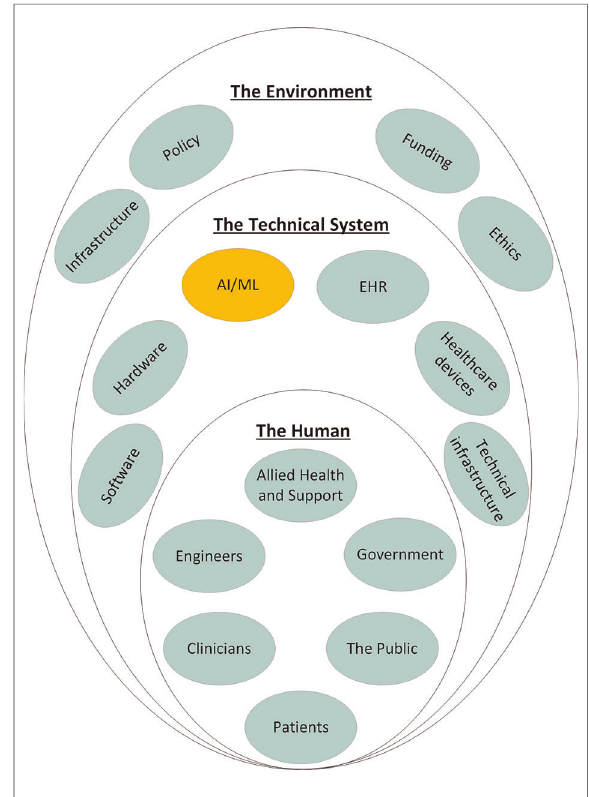
FIGURE 1 System of systems of healthcare and how applied machine learning should integrate into these existing systems. Each of the elements shown here in fl uence every other element in an interconnected network. Electronic Health Record (EHR); Arti fi cial Intelligence/ Machine Learning